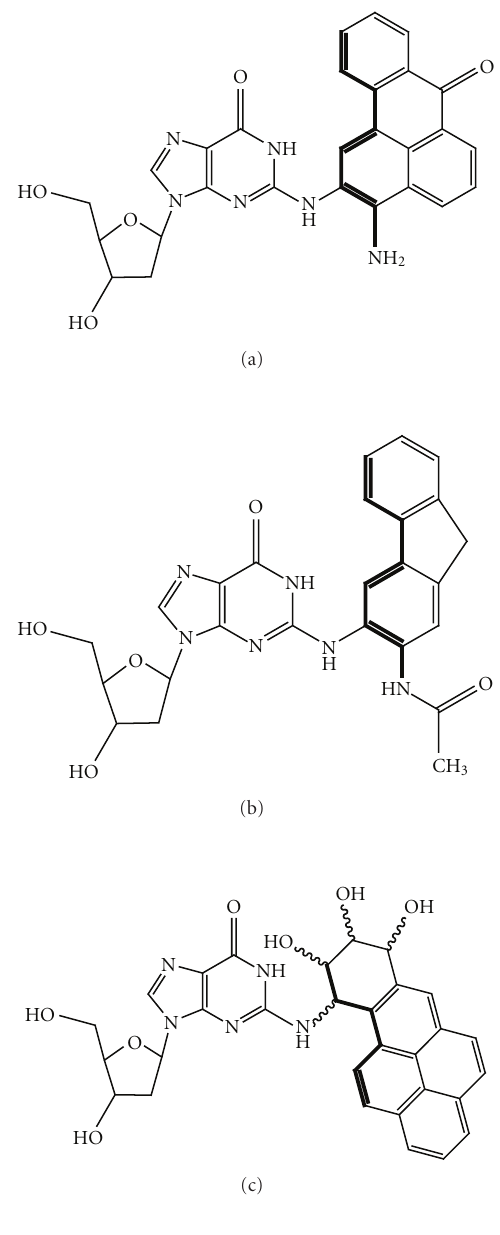
Figure 5: Bay regions (in bold) of dG- N 2 adducts formed by 3- nitrobenzanthrone (a), acetylaminofluorene (b), and B[a]P (c).